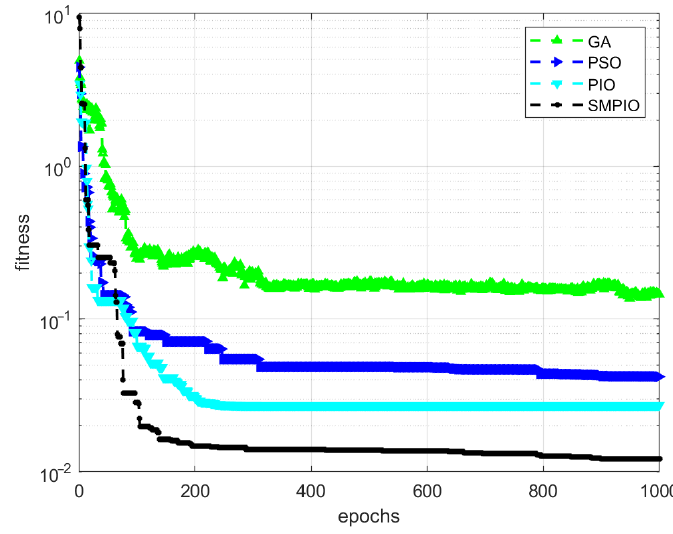
Figure 4. Fitness comparison of the GA, PSO, PIO, and SMPIO methods.